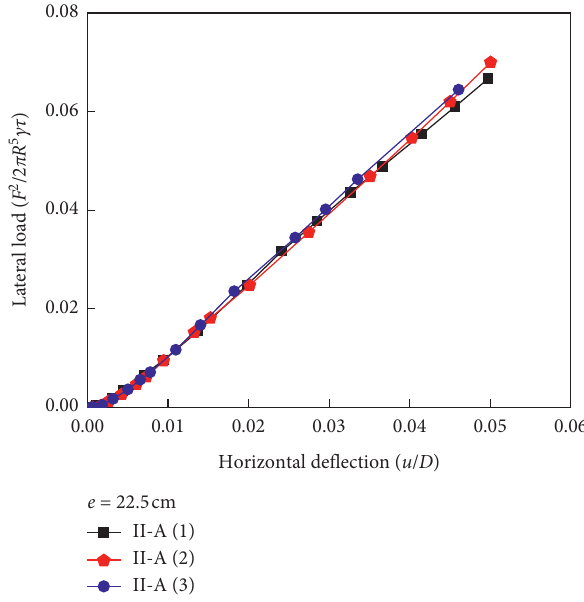
Figure 5: Lateral load versus horizontal deflection.